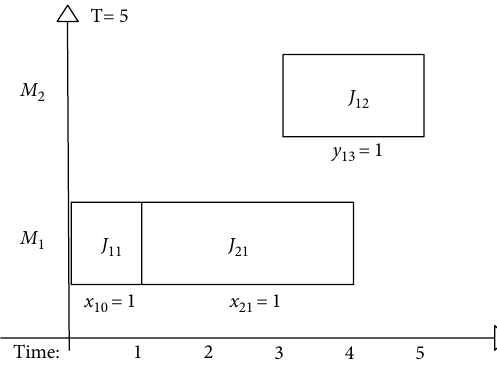
Figure 2: Scheduling violating the precedence constraints